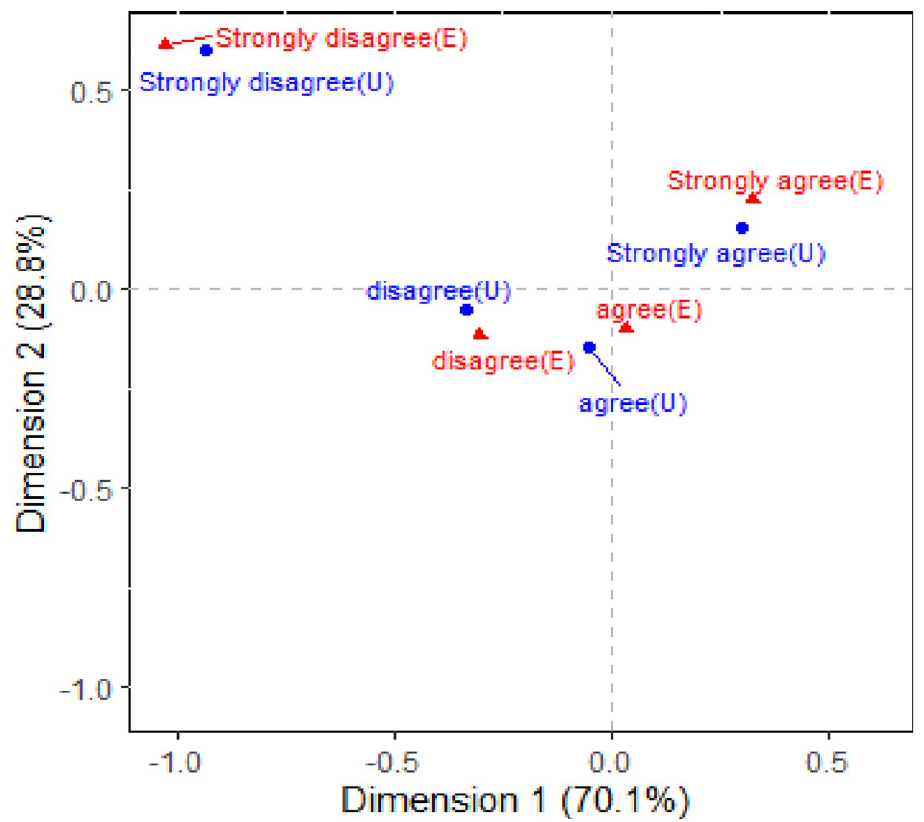
Fig 1. Two-dimensional correspondence plot of Table 1( Utility (U) and Efficacy (E)).